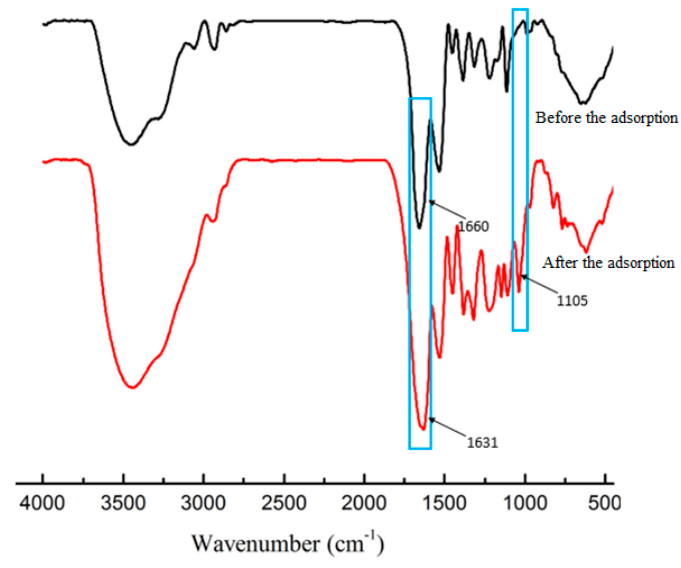
Figure 11. IR spectrum of the polymer before and after adsorption.